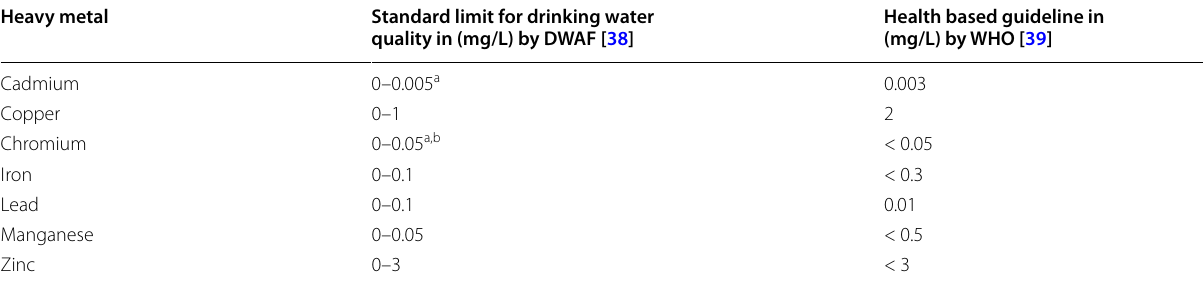
Table 2 Guidelines for drinking water quality set by South Africa and World Health Organisation